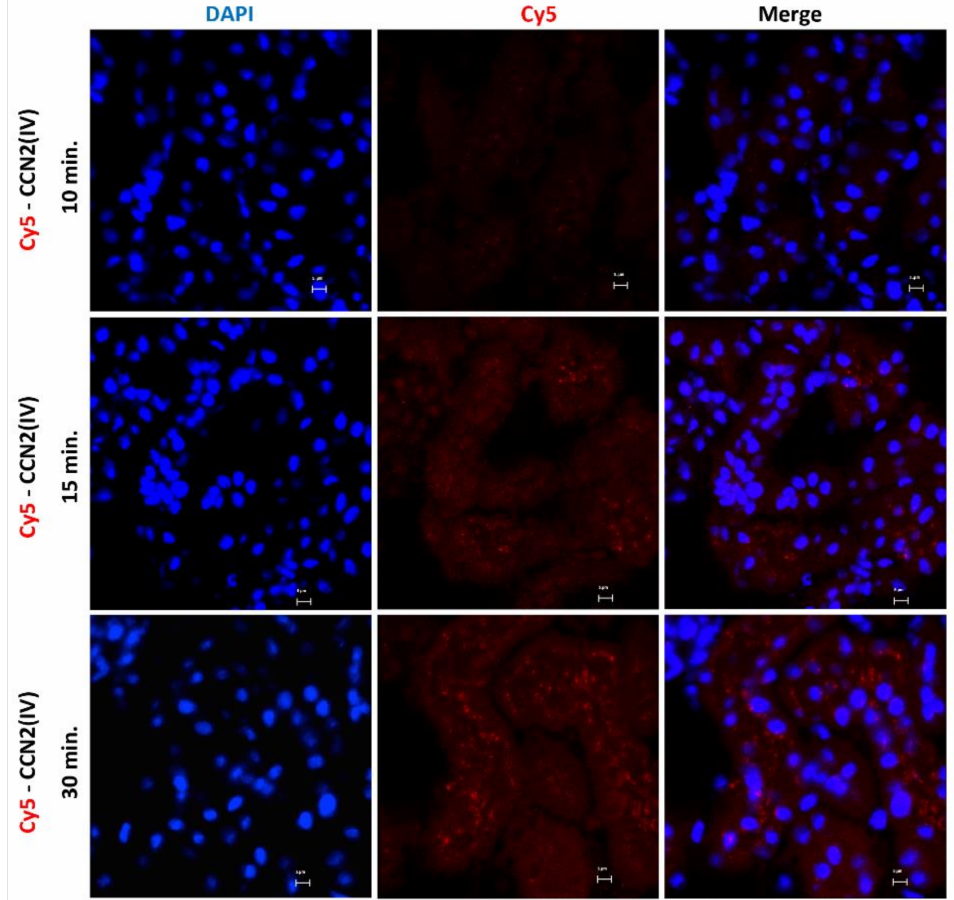
Figure 1. Evaluation of CCN2(IV) binding to renal tissue in the model of intra-renal injection. C57BL/6 mice were injected with Cy5-CCN2(IV) (dose of 2.5 ng/g of body weight, n = 3 mice per group) in the right kidney and sacrificed at different times (from 10 to 30 min). Frozen OCT-embedded renal samples were used for confocal microscopy. Red immunostaining (corresponding to CCN2(IV) labeled with Cy5 fluorophore) was found in tubular epithelial cells, showing CCN2(IV) binding to renal cells. Nuclei were stained with DAPI to distinguish renal structures. The overlaid images in red and blue (merge) indicated CCN2(IV) localization mainly in the membrane of tubuloepithelial cells. Figures show one representative mouse per group, and scale bar represents 5 µ